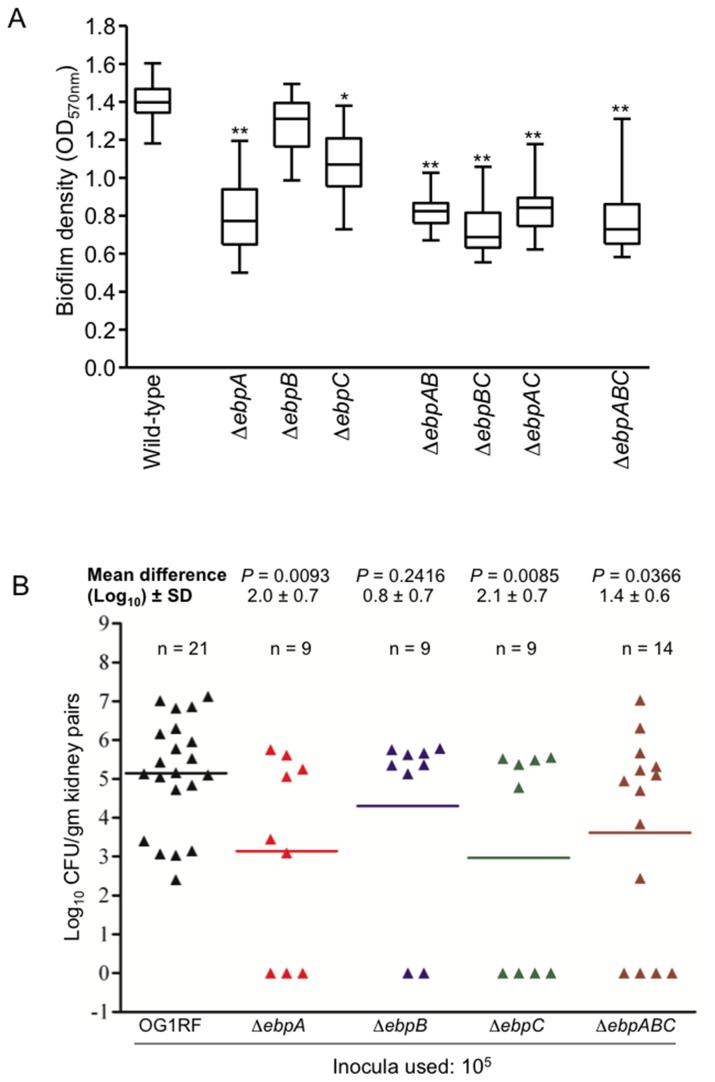
Effect of deletion of ebp genes in biofilm and in a murine model of UTI.(A) Comparison of biofilm formation by E. faecalis OG1RF and its ebp deletion derivates. Median OD570 values and interquartile ranges, with the minimum and maximum values marked by whiskers, represent combined data from three independent assays and 50 wells for each construct. Statistical analyses were performed by the Kruskall-Wallis test. *, P<0.001 versus WT OG1RF; **, P<0.001 versus WT OG1RF, ΔebpB and ΔebpC. (B) Monoinfection in a murine model of UTI by E. faecalis OG1RF and its isogenic mutants. Mice were infected with 105 CFU and results are expressed as log10 CFU per gram from kidney-pair homogenates 48 h after transurethral challenge. A value of 1 was assigned to those kidneys with 0 CFU for statistical analyses. Black triangles represent WT OG1RF, red triangles OG1RFΔebpA, blue triangles OG1RFΔebpB, green triangles OG1RFΔebpC, and brown triangles OG1RFΔebpABC. Horizontal bars represent geometric means. The mean difference in CFU counts of ebp mutants versus OG1RF is given as log10 ± standard deviation (SD). Differences in log10 CFU of OG1RF versus ΔebpA, ΔebpB, ΔebpC and ΔebpABC were evaluated by the unpaired t test.